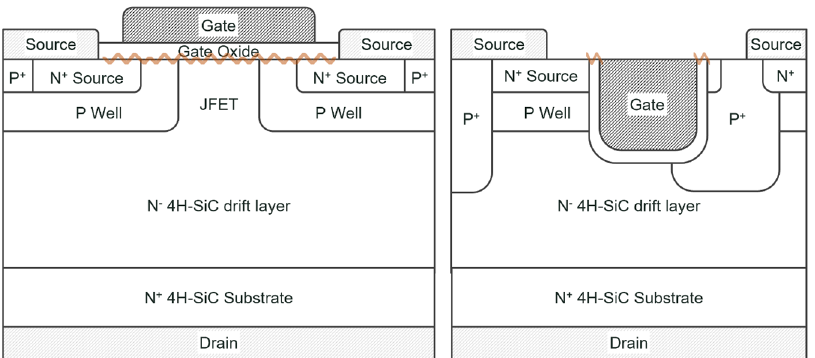
Figure 9. Schematic structure of planar and trench MOSFET [18]. The above figure is reproduced from reference [18].